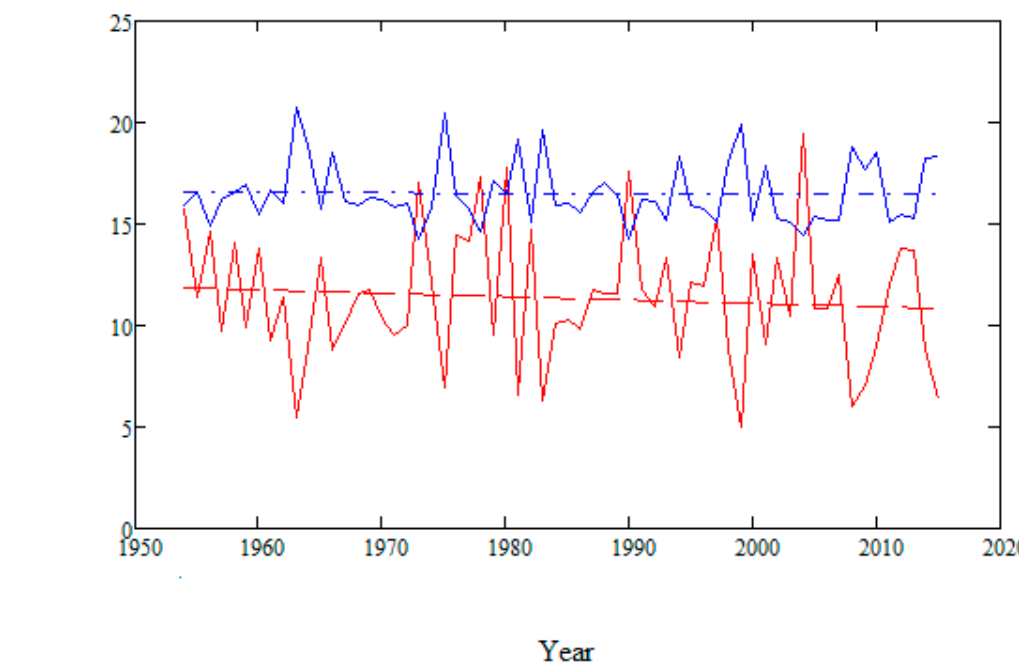
Figure 9. As in Figure 6, except for sugar content of beet (blue - %) and HTC (red – mm ◦ C − 1 ), respectively. The variable HTC is multiplied by 10 in order to fit the data to the graph software. The linear regression models are also shown, where the red line is the HTC (mm ◦ C − 1 ) and the blue line is sugar content (%).